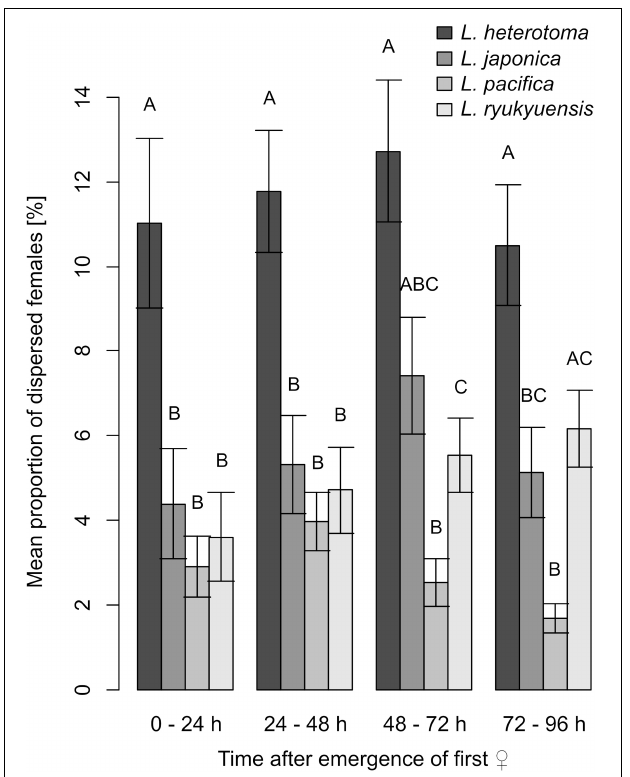
FIGURE 4 | Barplots showing means and standard errors of the mean proportions of dispersed females within 24-h intervals after emergence of the first female in each jar for each of the species L. heterotoma , L. japonica , L. pacifica , and L. ryukyuensis . Differences between species within time intervals were analyzed using Kruskal–Wallis rank sum tests with post hoc pairwise Wilcoxon signed rank tests (Bonferroni corrected). Different letters indicate a significant difference, P < 0.05. For each experiment, N = 30.